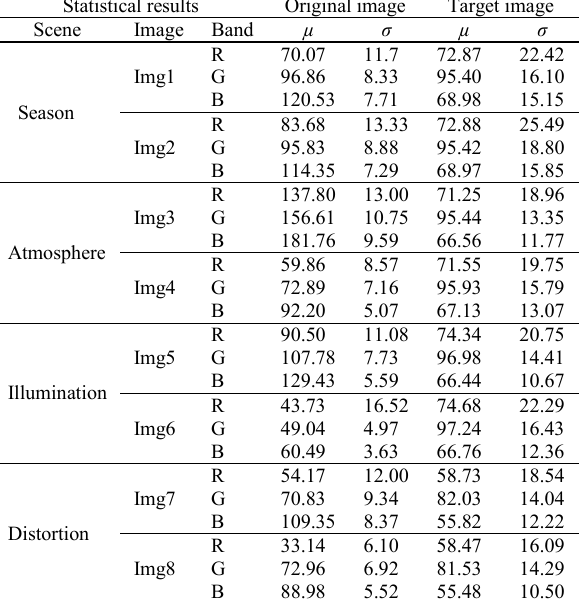
Table 1 Statistical results of images overlapping areas before and after color correction.